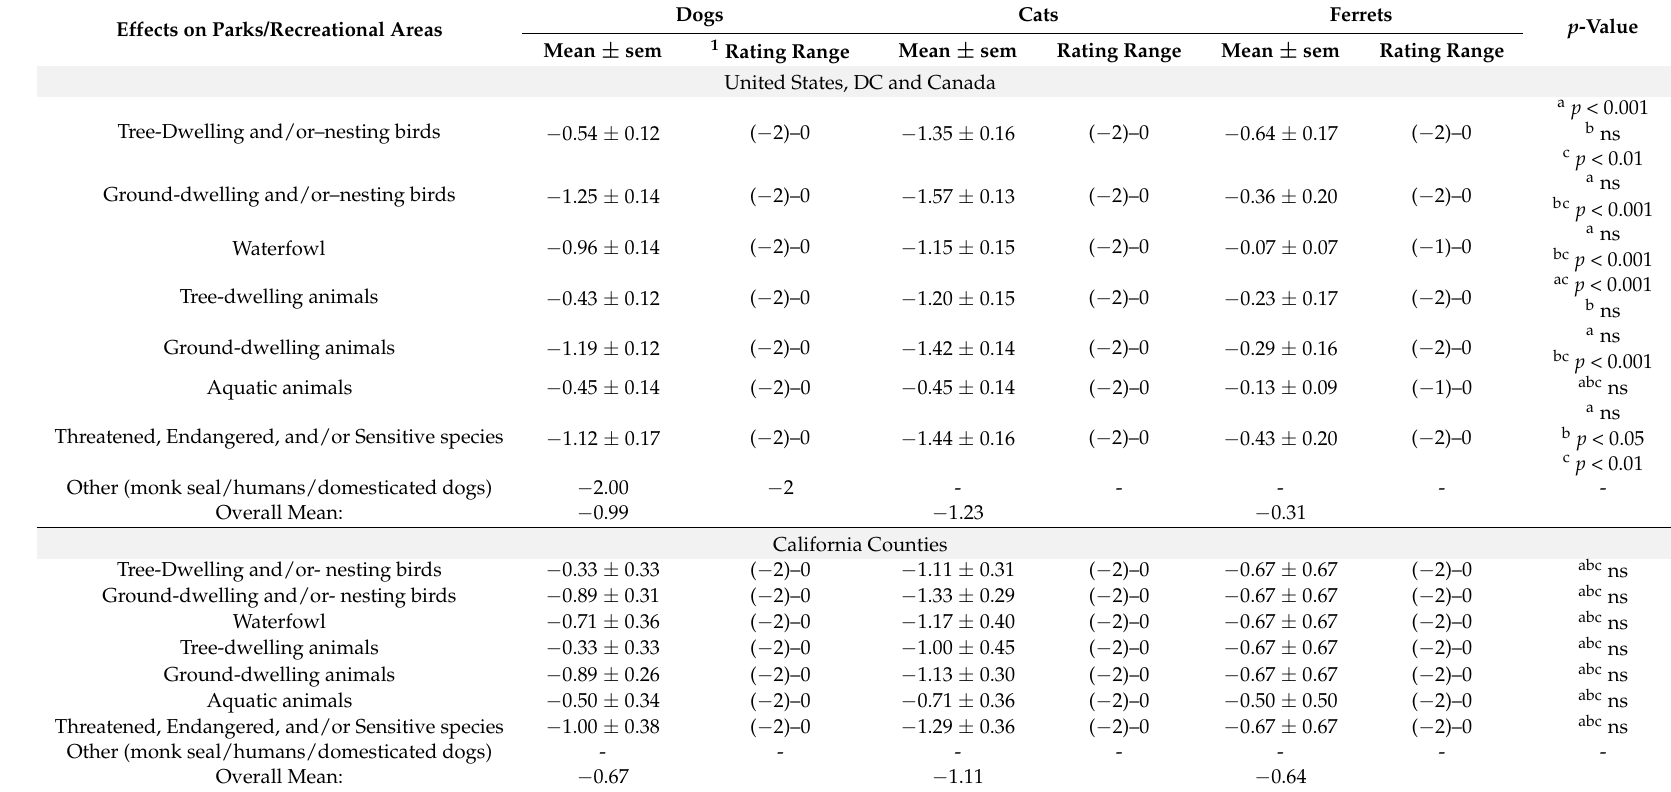
Table 4. “Degree of concern” regarding the effects (impact) of unconfined animal on wildlife in parks and recreational areas. Effects on Parks/Recreational